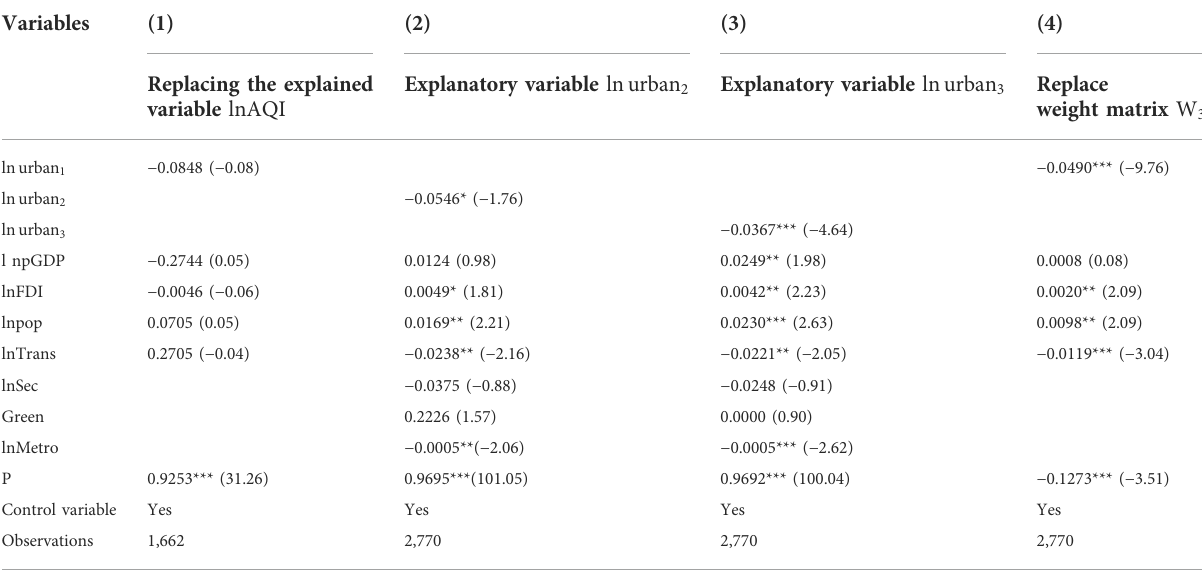
TABLE 5 Regression results of replacing the interpreted variable.